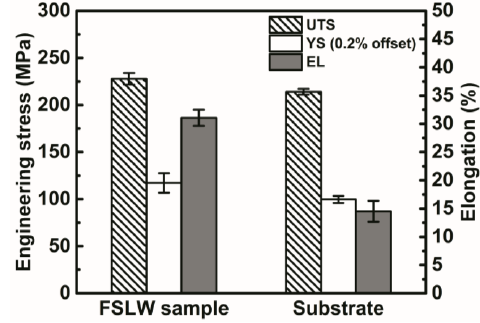
Figure 10. Tensile properties of FSLW samples and rolled 2024-O substrate.